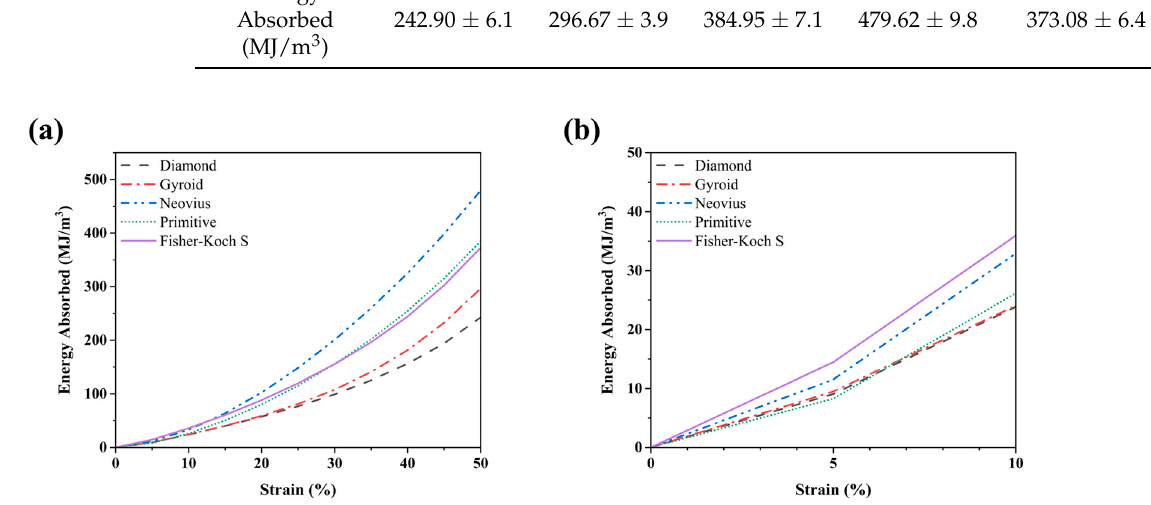
Figure 8. ( a ) Energy absorption–strain curves for the different functionally graded lattice specimens from 0 to 50% strain. ( b ) Energy absorption–strain curves of the fabricated samples with 0 to 10% strain.